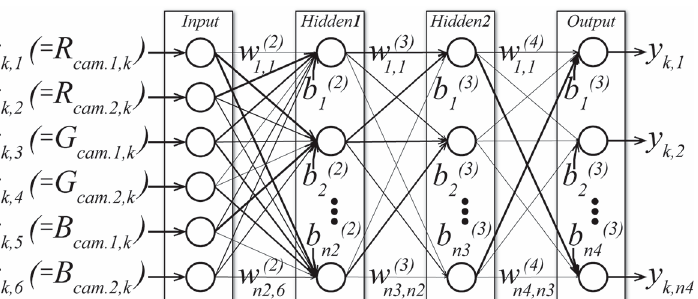
Figure 1. The architecture of our ANN with two hidden layers and a variable number of hidden neurons, employed for the reconstruction of reflectance spectral components from 1 to 3 camera RGB responses.